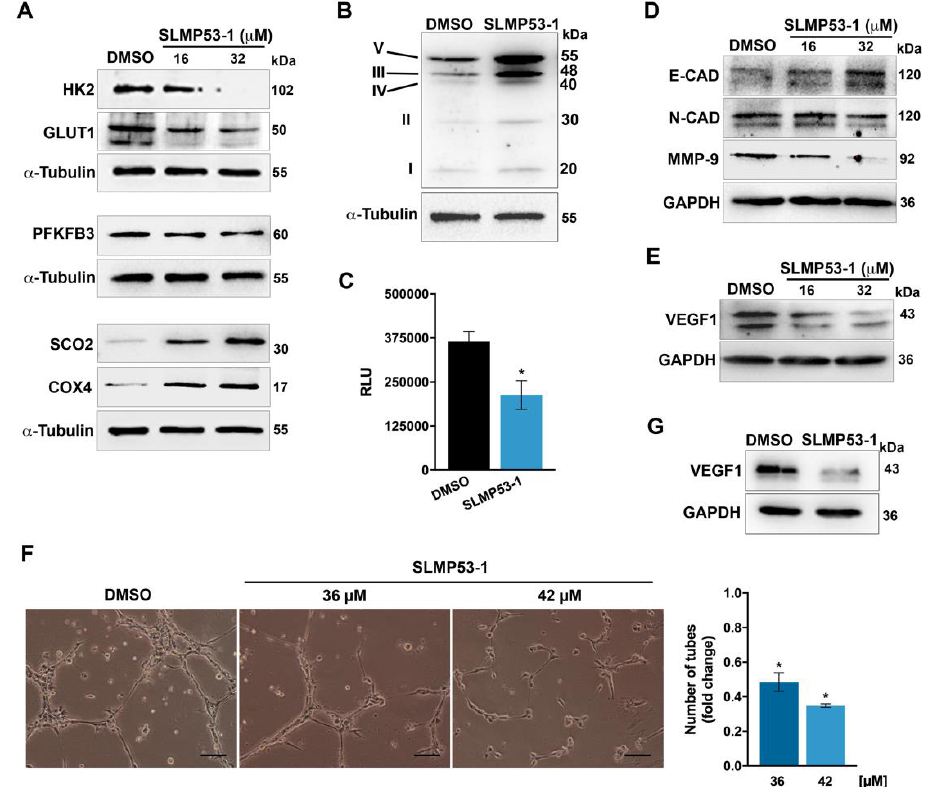
Figure 1. SLMP53-1 modulates the Warburg e ff ect and angiogenesis in cancer cells, with impact on ECM remodeling and EMT events in vitro. ( A ) Expression levels of proteins involved in glycolysis and OXPHOS after 24 h treatment with SLMP53-1, in HCT116 cancer cells. ( B ) Expression levels of OXPHOS mitochondrial complexes I–V, after 24 h treatment with 16 µ M SLMP53-1, in HCT116 cells. ( C ) E ff ect of 16 µ M SLMP53-1 on lactate secretion by HCT116 cells, after 24 h treatment. Relative luminescence units (RLU) signal was normalized to the respective cell number and corresponds to mean ± SEM of three independent experiments. Values significantly di ff erent from DMSO (* p < 0.05; unpaired Student’s t -test). ( D , E ) Expression levels of proteins involved in migration ( D ) and angiogenesis ( E ) after 24 h treatment with SLMP53-1, in HCT116 cells. ( F ) Anti-angiogenic e ff ect of SLMP53-1, in HMVEC-D cells, after 12 h treatment, using the endothelial cell tube formation assay. Representative images are shown (scale bar = 50 µ m and magnification = × 100; zoomed-out pictures are shown in Supplementary Figure S1A). Quantification of tube-like structures in five randomly selected microscopic fields; fold changes are relative to solvent (DMSO) and correspond to mean ± SEM of three independent experiments. Values significantly di ff erent from DMSO (* p < 0.05; one-way ANOVA with Dunnett’s multiple comparison test); quantification of total tube length, using Image J software, is shown in Supplementary Figure S1B. ( G ) Expression levels of VEGF1, after 48 h treatment with 42 µ M SLMP53-1, in HMVEC-D cells. In ( A , B , D , E , G ), immunoblots are representative of three independent experiments; α -tubulin or GAPDH were used as a loading control.